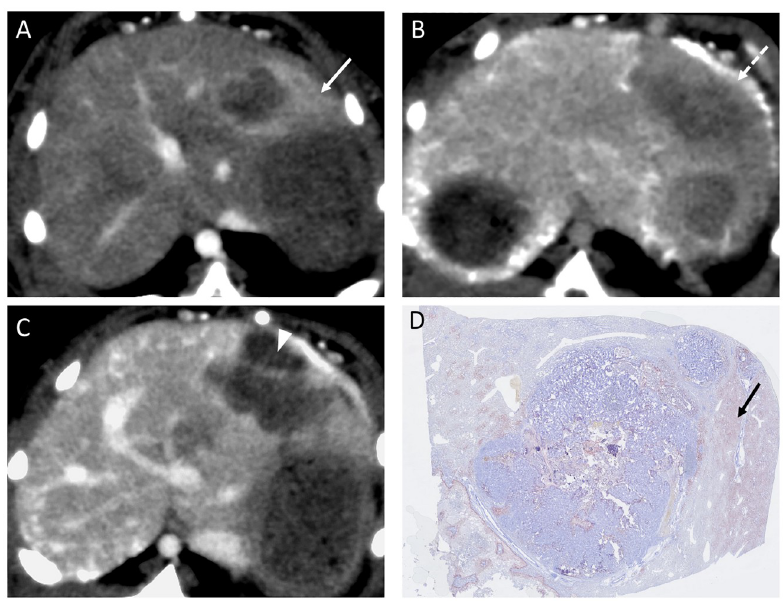
Fig 7. Representative images showing poor Lipiodol accumulation in a rabbit in the experimental group. (A) A massive arterioportal shunt around the tumor (white arrow). (B) Lipiodol accumulation higher in the liver parenchyma than in the tumor immediately after TACE (white dashed arrow). (C) Necrosis in liver parenchyma surrounding the tumor two days after TACE (white arrowhead). (D) Lipiodol accumulation in normal liver parenchyma in specimen stained with Oil red O (black